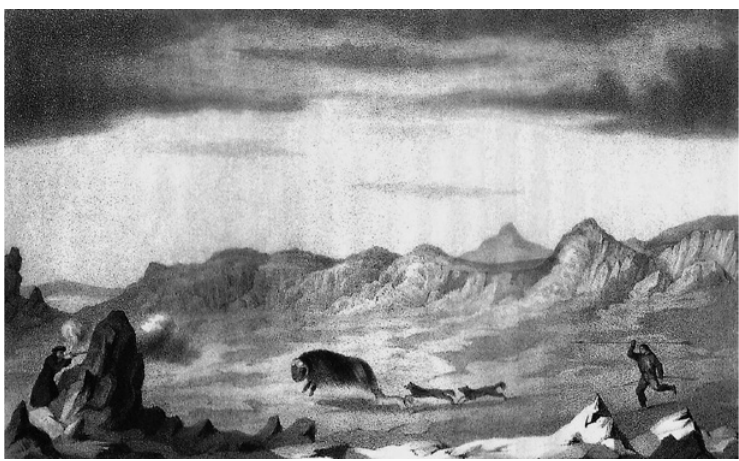
Figure 6. James Ross shooting a musk-ox . Source : Ross, Second Voyag e, 350. Note : stripes are in the